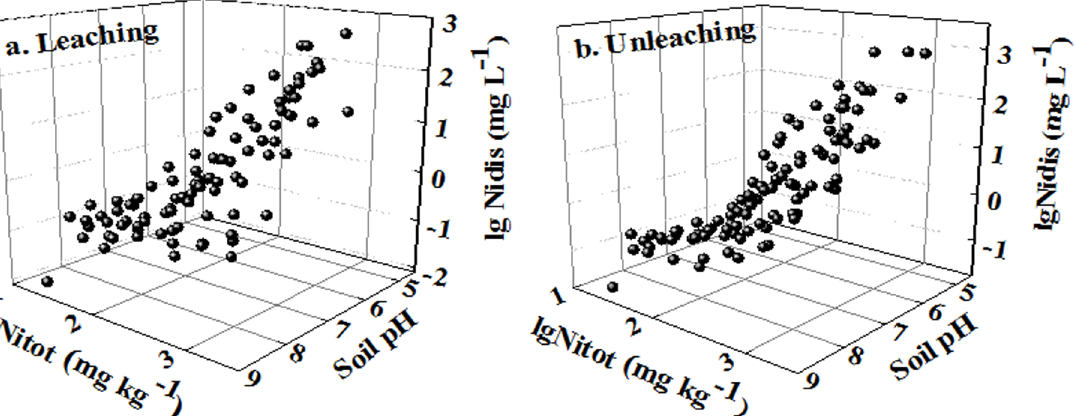
Fig 1. Soluble Ni concentrations as a function of total Ni concentrations and soil pH (Ni tot and Ni dis represented total Ni concentration in soil and the soluble Ni concentration in soil pore water, respectively).